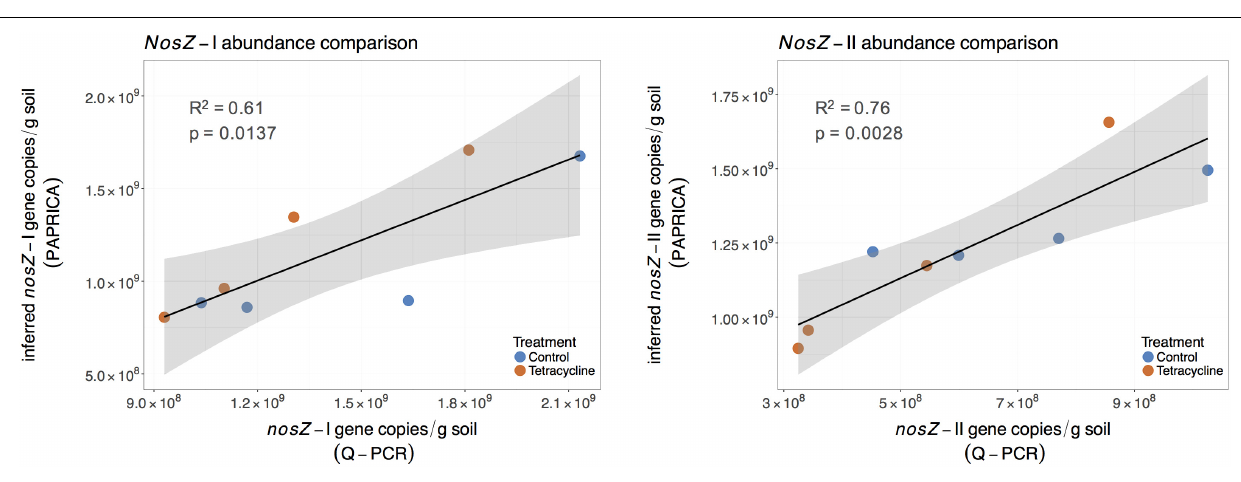
FIGURE 8 | Linear regressions comparing inferred and quantified nosZ gene abundances for control (blue) and tetracycline (red) samples. The inferred nosZ abundances were calculated by multiplying the relative abundances obtained through metabolic inference (PAPRICA) with the 16S rRNA gene abundances. The shaded area represents the 95% confidence interval of the linear regression